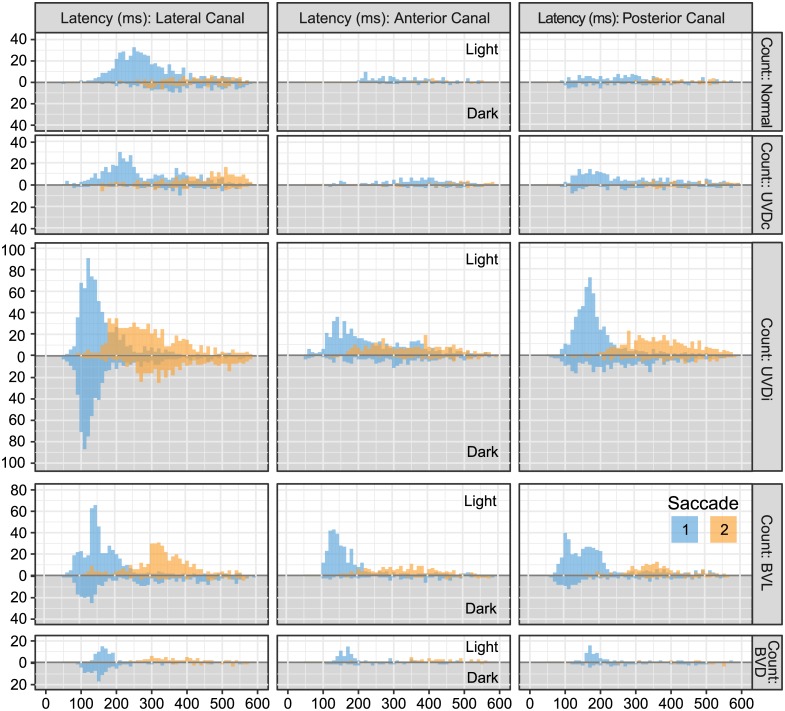
The influence of visual fixation on the number of saccades: First saccades are affected to a lesser degree than the second saccade.The white background shows the number of saccades observed with visual fixation, while the dark background shows the number of saccades without visual fixation. In lesioned ears (UVDipsi, BVL, BVD) the number of first and second saccades decreases in the dark. Since the number of impulses recorded from the vertical (AC, PC) and lateral canals (LC) were dissimilar (Table 1), the findings for these two groups should not be compared. UVDc = unilateral vestibular deafferention contralesion, UVDi = unilateral vestibular deafferention ipsilesion, BVL = bilateral vestibular loss, BVD = bilateral vestibular deafferentation.